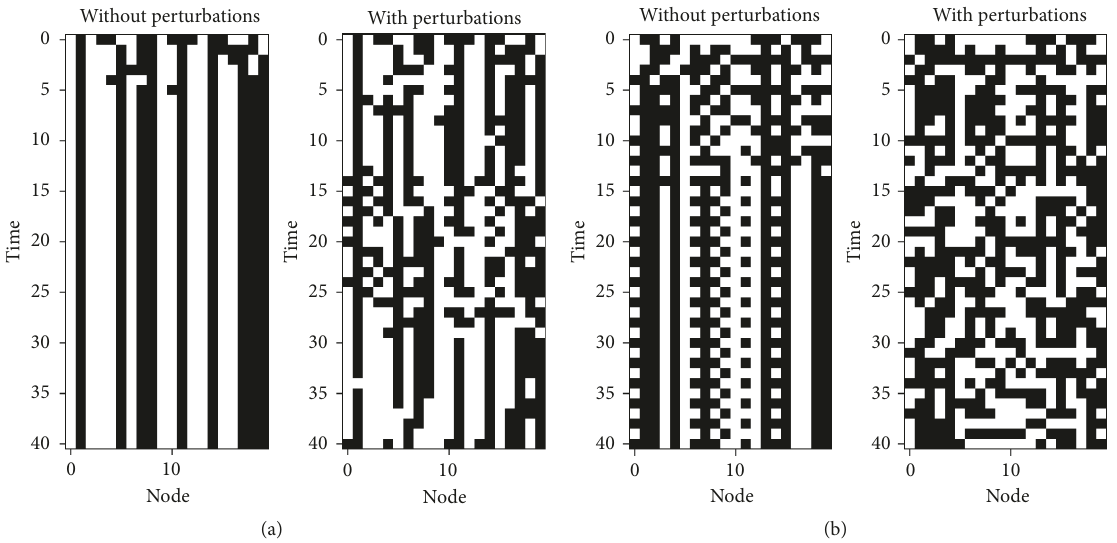
Figure 1: Schematic diagrams showing state transitions of (a) critical and (b) chaotic RBNs with 𝑁 = 20, 𝑋 = 2, and 𝑂 = 1. The left side is the network without perturbations and the right one is the network with perturbations with the same initial states. Each square represents the state of a node (white = 0, black = 1). The state transitions were calculated from the initial states at the top to states at the bottom during 𝑇 = 40. (a) 𝐾 = 2 (critical), ∮ = −0.0958 (complexity is increased by perturbations: antifragile). (b) 𝐾 = 3 (chaotic), ∮ = 0.0388 (complexity is decreased by perturbations: